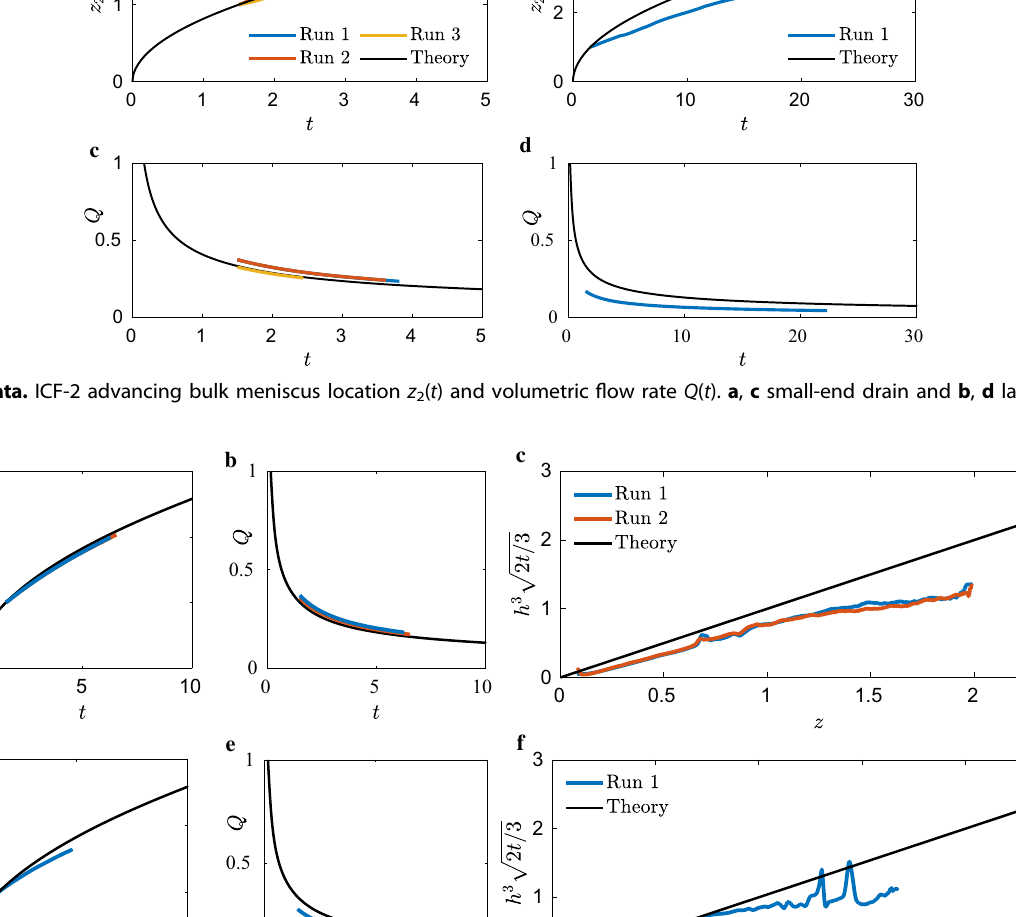
ffiffiffiffiffiffiffiffiffi p 2 t = 3 , each overlaid with theory (black), Eqs. (7), (6), and (5),